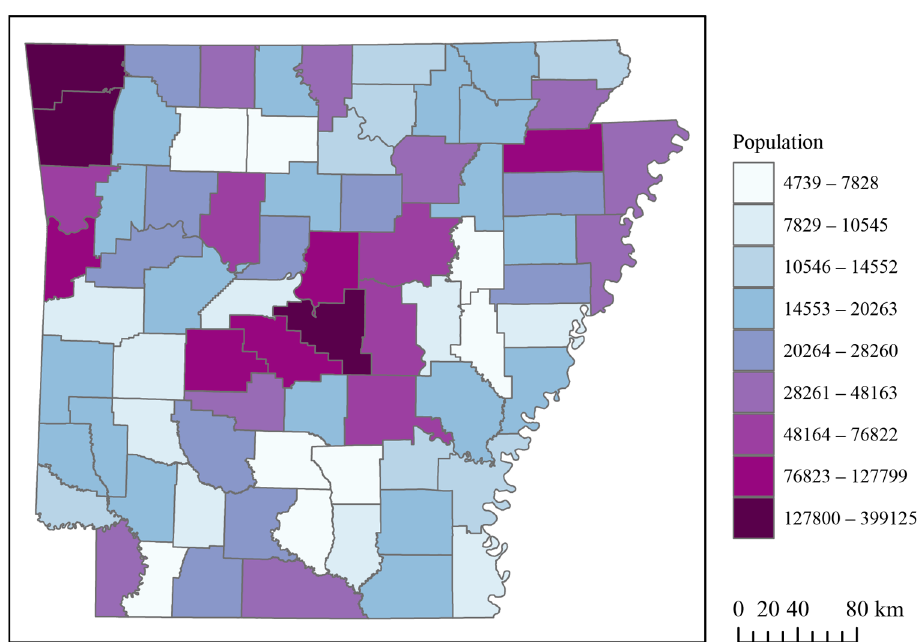
Figure A2. Correlation coefficients among different variables in 2021 DJF after backward selection.